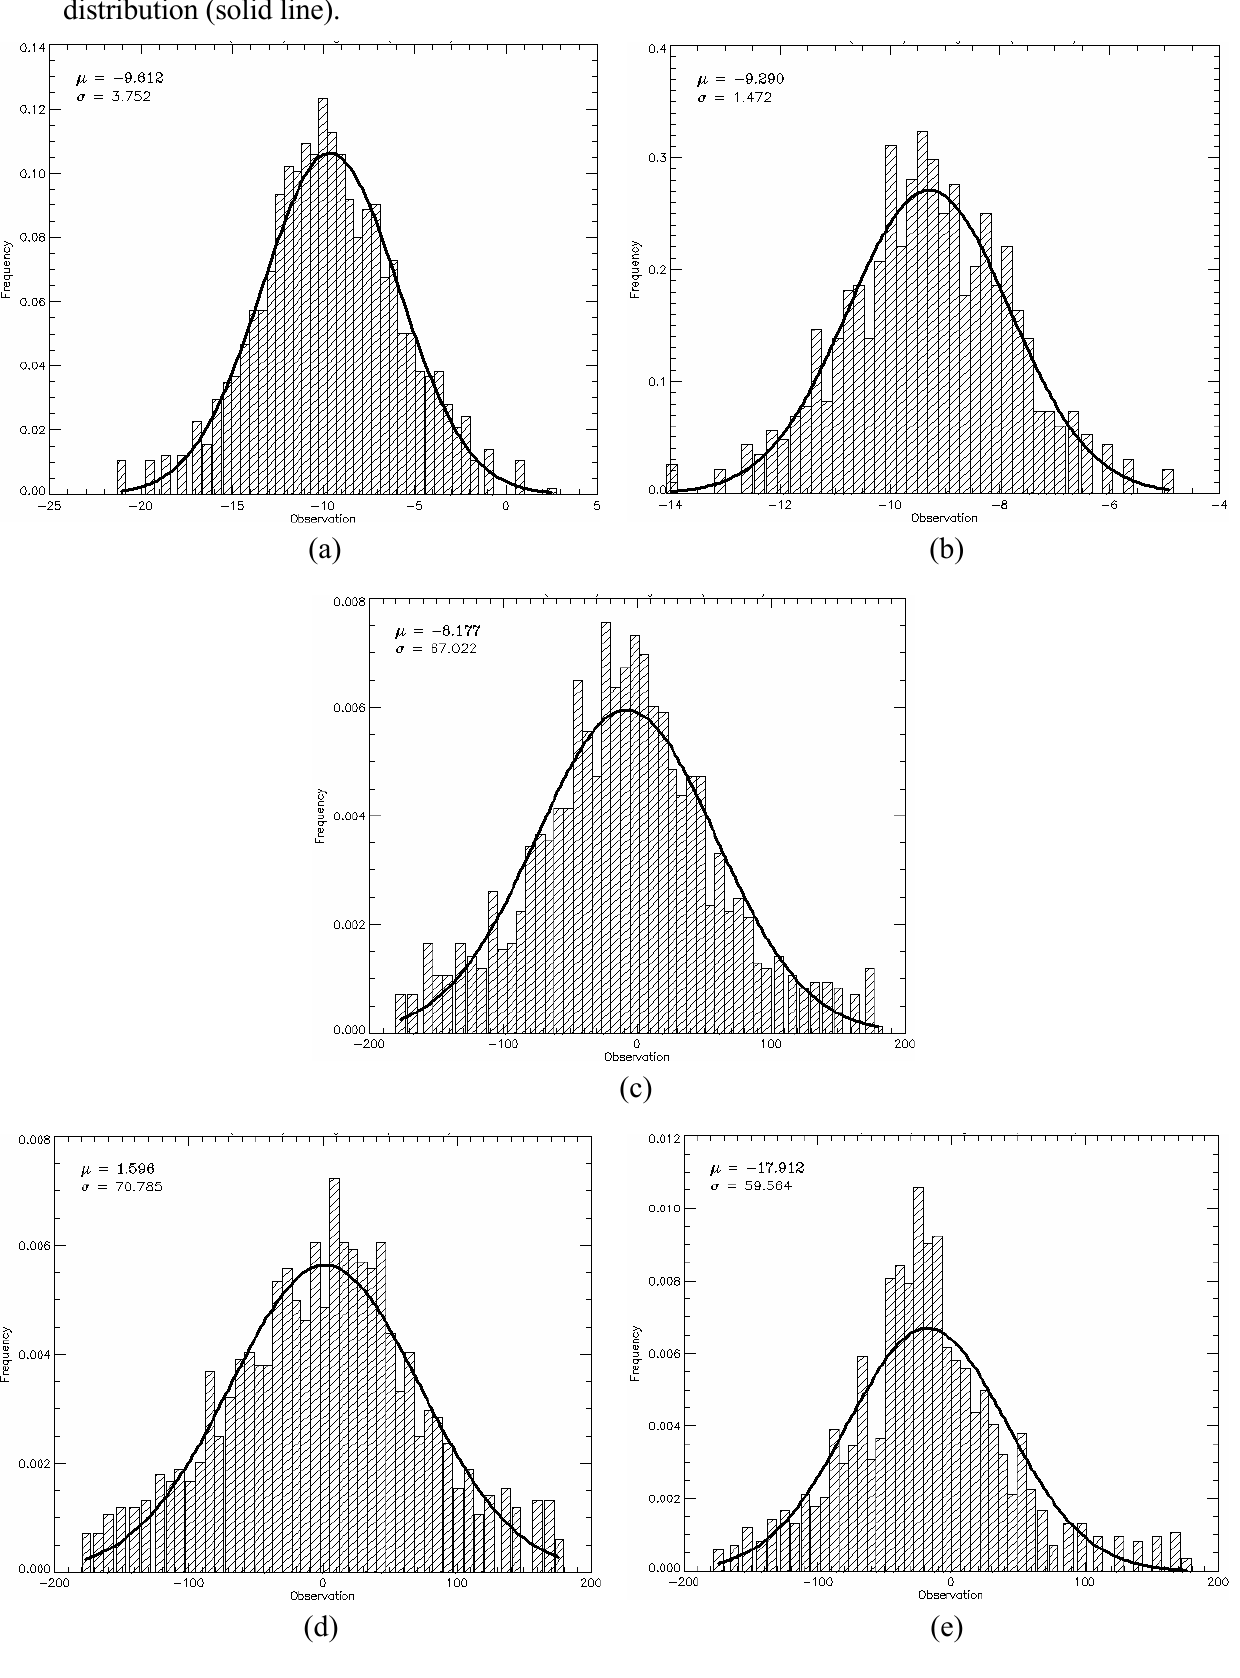
Figure 19. C-band PPD ’s histogram for all regions in comparison to theoretical Gaussian distribution (solid